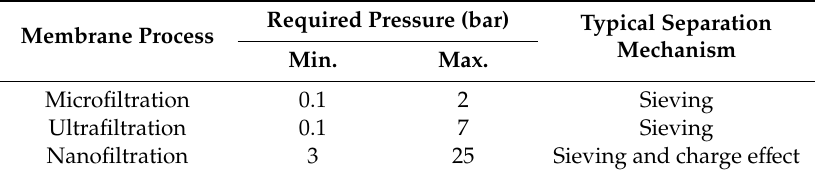
Table 1. Classification and main parameters of Microfiltration (MF), Ultrafiltration (UF) and Nanofiltration